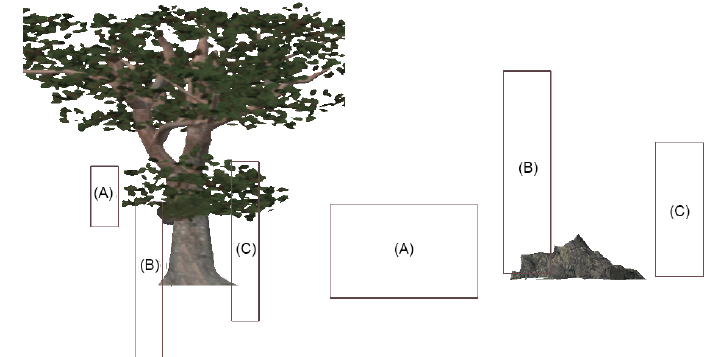
Figure 7. A lateral view of the meshes composing the two types of obstacles and their associated three intersection bounding boxes, assuming that the avatar approaches the obstacles from the left. Boxes labelled as ( A ) are used for detecting ray–obstacle intersections (to determine which object is being attended by the player). In the case of the tree, box ( A ) surrounds the tree’s horizontal hanging branch, that is, the actual obstacle to the avatar (see Figure 5). Boxes labelled as ( B ) are used to detect the moment the avatar is about to collide against the obstacle. Boxes labelled as ( C ) allow the system to detect the moment the avatar passes beyond the obstacle.